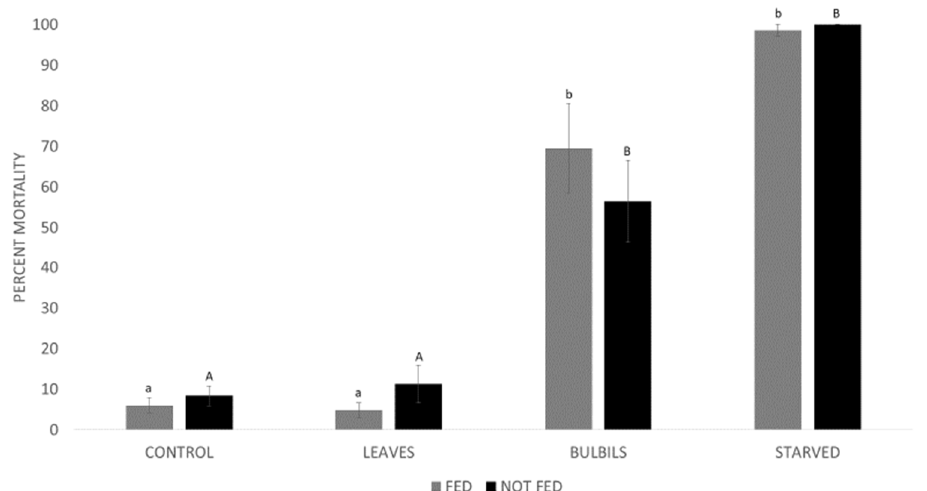
Figure 1. Percent mortality of air potato beetles on four diets after a one week feeding period (FED) on air potato leaves or testing at emergence (NOT FED). Letters indicate statistically significant differences in the two separate analyses. Results show mortality at the end of each experiment which was one month (FED) or 12 days (NOT FED). Table 1. The number of the two biotypes of beetles, Chinese and Nepalese, produced and released annually by the Gainesville facility. The grand totals of beetles produced and released from 2014–2021 include the number of sites where beetles were released in Florida and five other states. The asterisks in the “Release Sites” column denote the following: In 2014–2015 the number of counties in Florida is reported rather than the total number of release sites. Beetles were only released in Florida in this